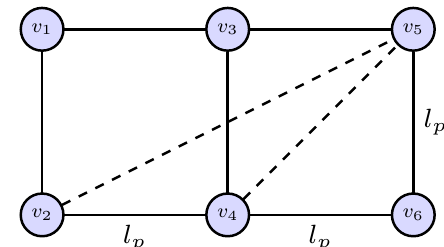
Fig. 2 A small patch of a d = 2 emerged mesh. The presence of the links (v 2 ,v 5 ) and (v 4 ,v 5 ) violate conventional locality. Without these links v 5 is not in the local neighborhood of v 2 or in the neighborhood of any of v 2 ’s neighbors. With the links established v 2 is now ’local’ to a node that is distant to all of the points in the node’s neighborhood